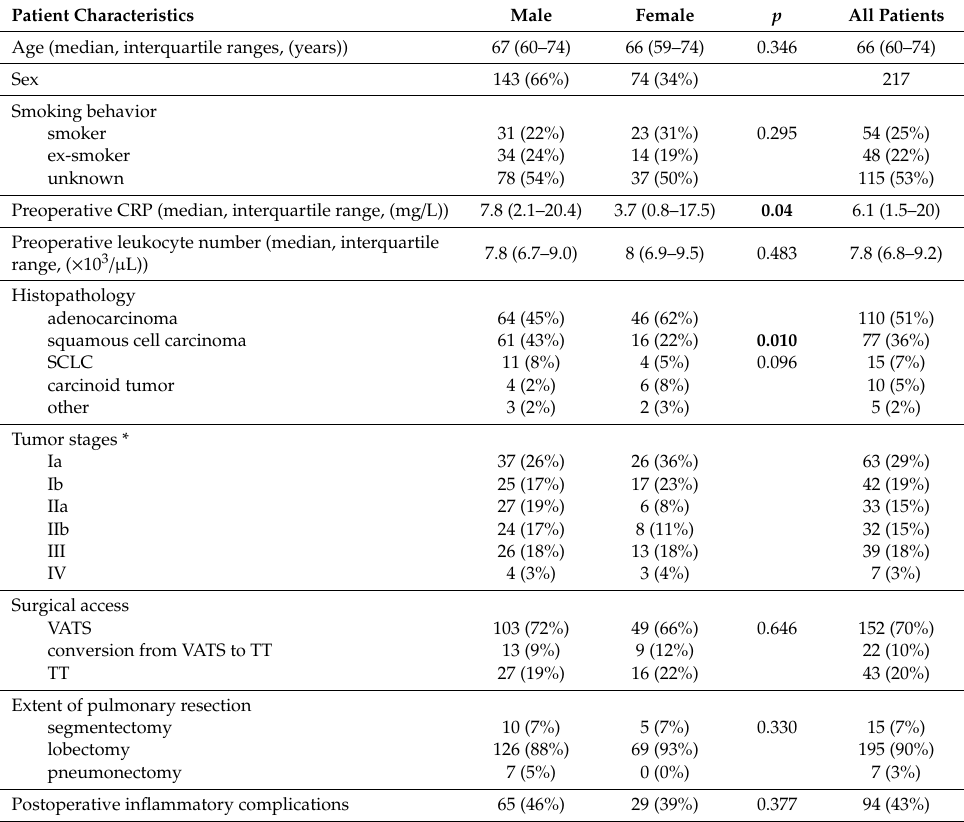
Figure 1. Flow chart of patients undergoing pulmonary resection included in this study stratified for surgical access; VATS, video-assisted thoracic surgery. Table 1. Characteristics of pulmonary cancer patients included in this study stratified according to gender.